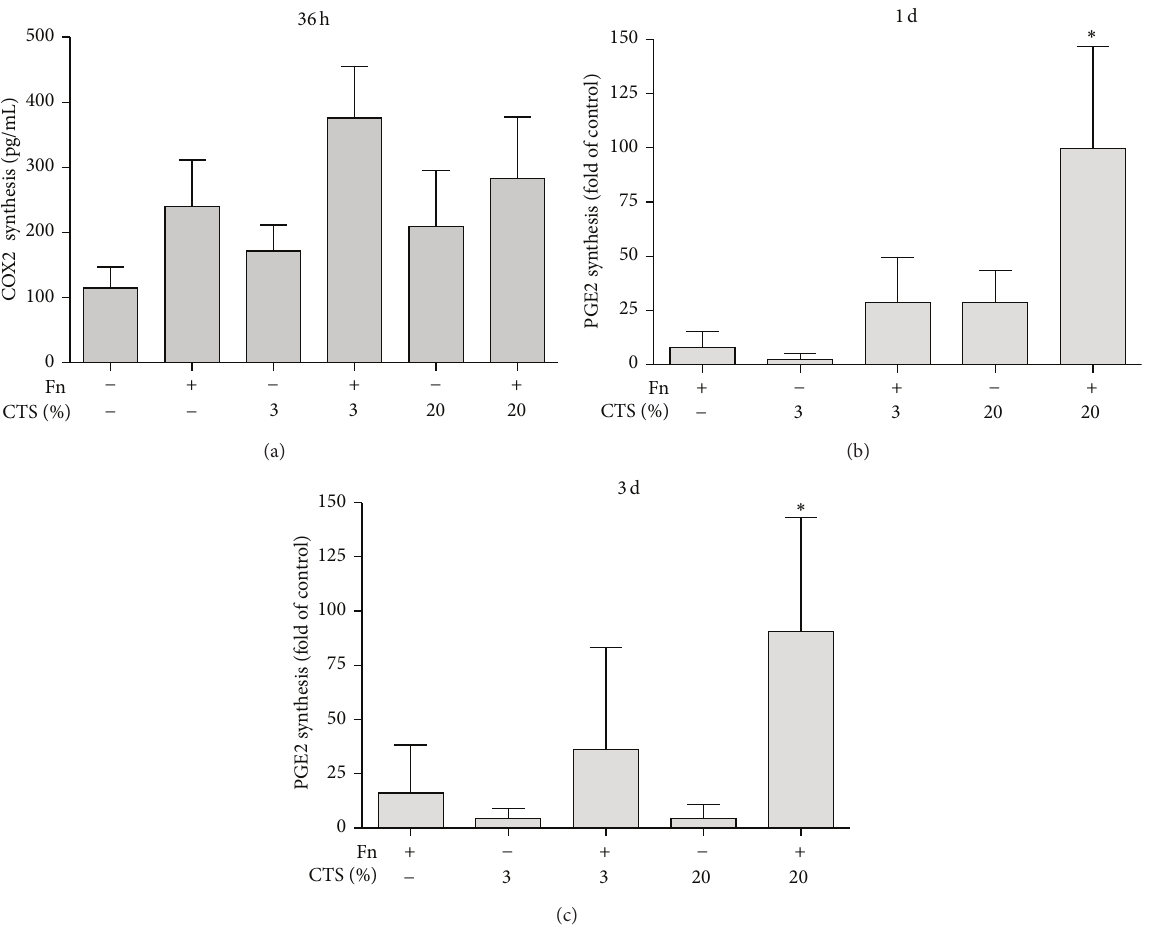
Figure 2: (a) Synthesis of COX2 in lysates of PDL cells treated with F. nucleatum ATCC 25586 and/or cyclic tensile strain (CTS) of low (CTSL, 3%) and high (CTSH, 20%) magnitudes at 36 hours. (b and c) Production of PGE2 in supernatants of PDL cells treated with F. nucleatum ATCC 25586 and/or CTSL and CTSH at 1 day (b) and 3 days (c). ∗ Significant difference compared to other groups ( 𝑃 < 0.05